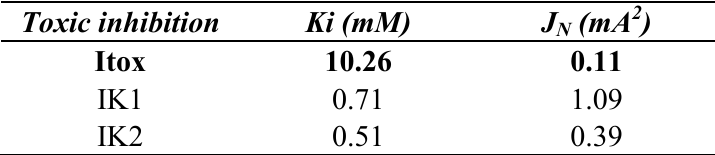
Table S4C. Ferricyanide 2